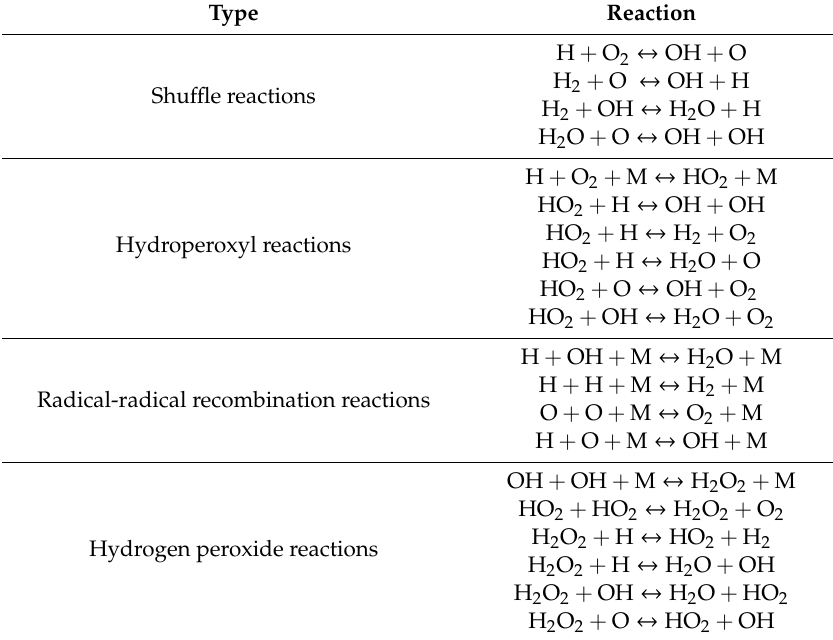
Table 5. 20 reversible elementary reactions in San Diego mechanism for hydrogen combustion. Reproduced from Ref. [12], Elsevier Ltd: 2013.